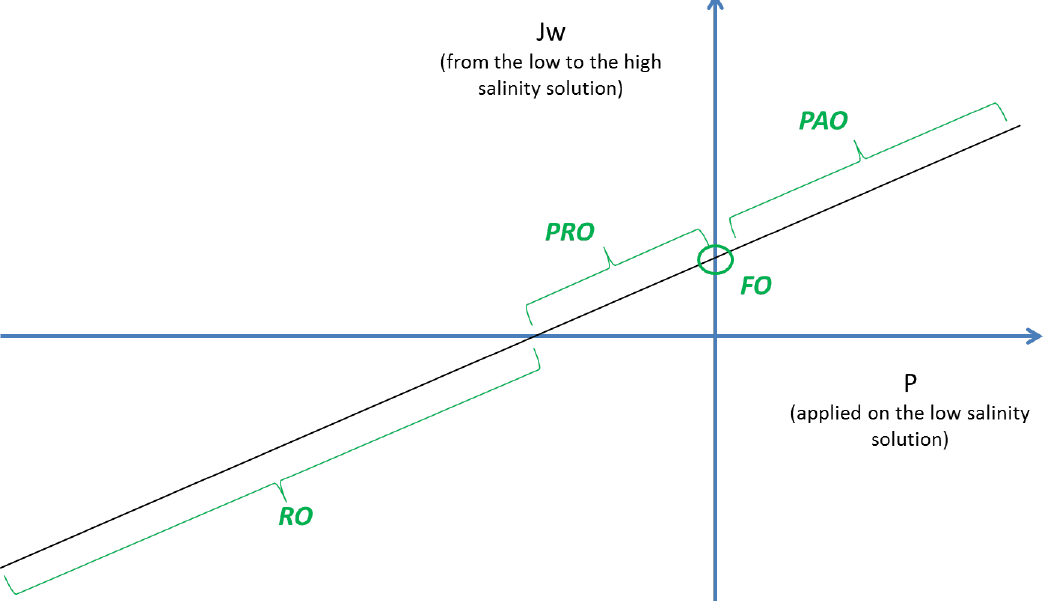
Figure 7. Illustration of water fluxes obtained (J w ) in osmotic processes as a function of hydraulic pressure applied (P) on the low salinity solution, and the potential of PAO to provide high fluxes.